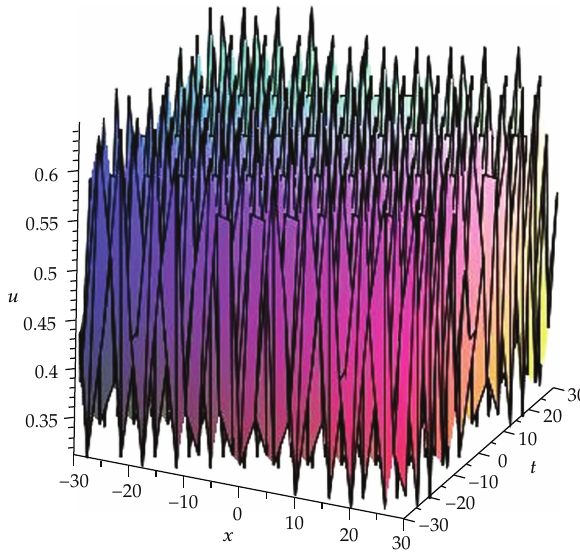
Figure 8: The solution u 9 of GSWW equation with k (cid:7) 0 . 3, c (cid:7) 2, α (cid:7) 3, β (cid:7)